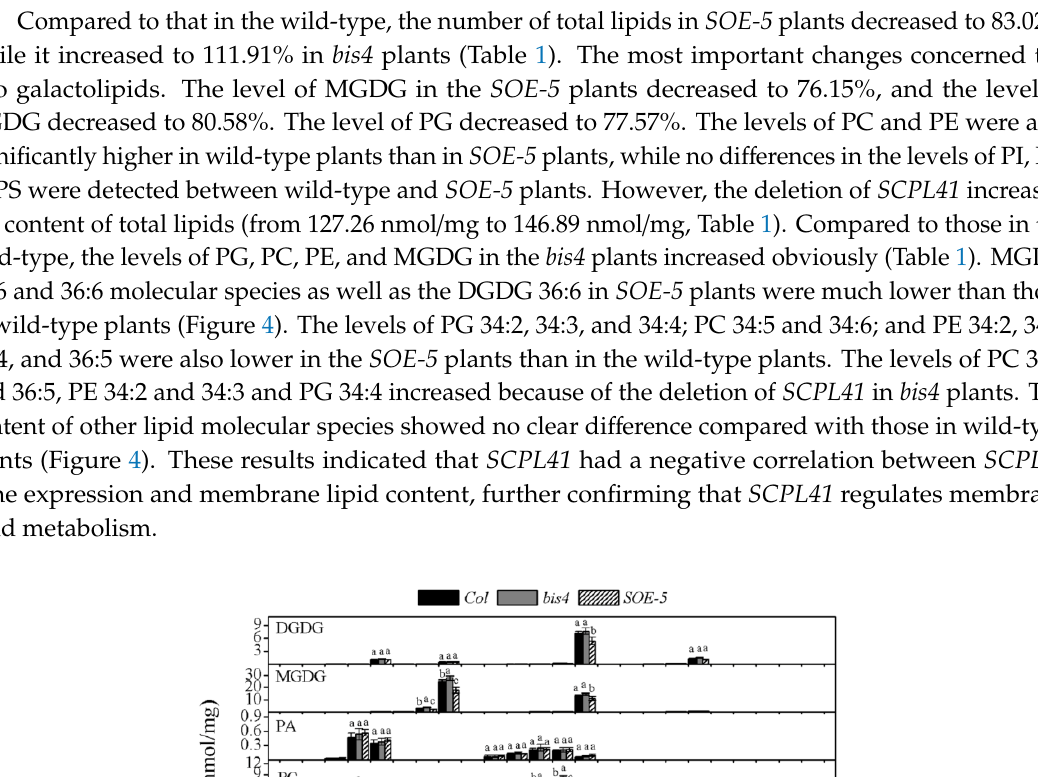
Table 1. Total lipids in Col , bis4, and SOE-5 plants.